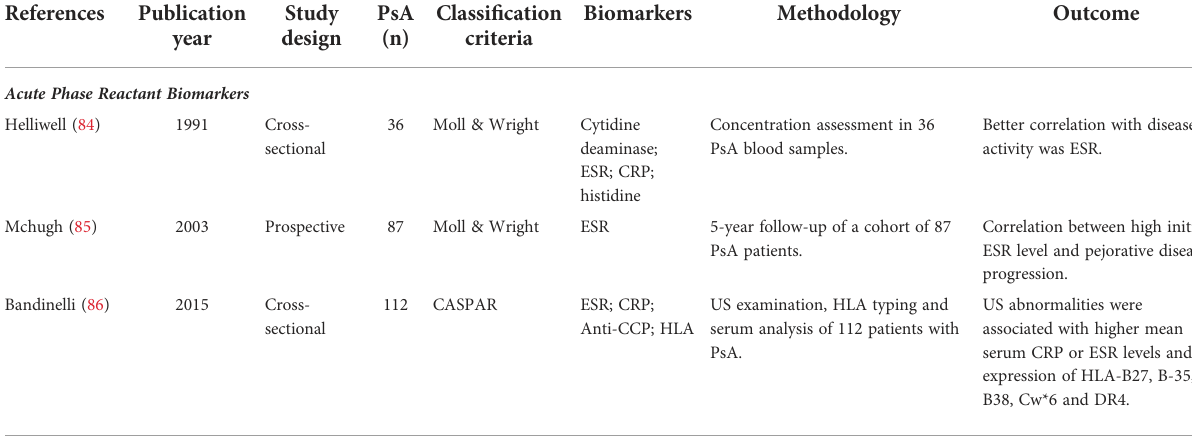
TABLE 2 Included Prognostic Biomarkers